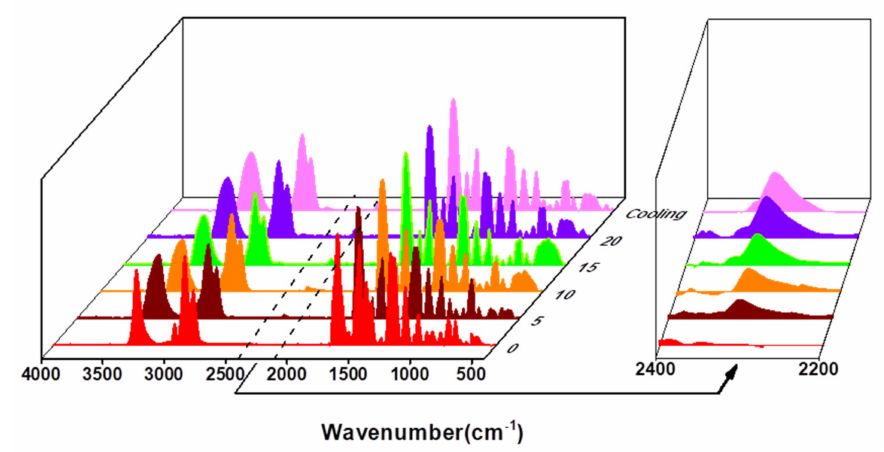
Figure 10. The IR spectra of P(Syol-HDI) vs. different heating time.